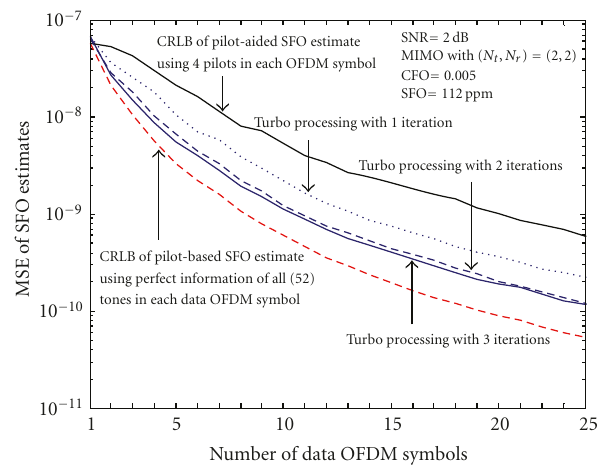
Figure 6: MSE and CRLB of SFO